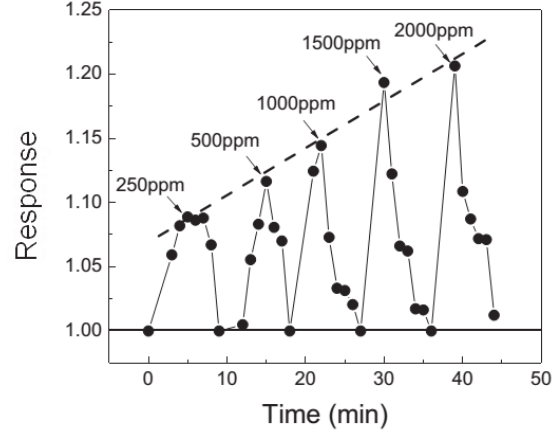
Figure 19. Recovery characteristics of Nb-doped TiO 2 (10 layers) sensor at a T w = 400 °C, from ref. [89]. Ref.